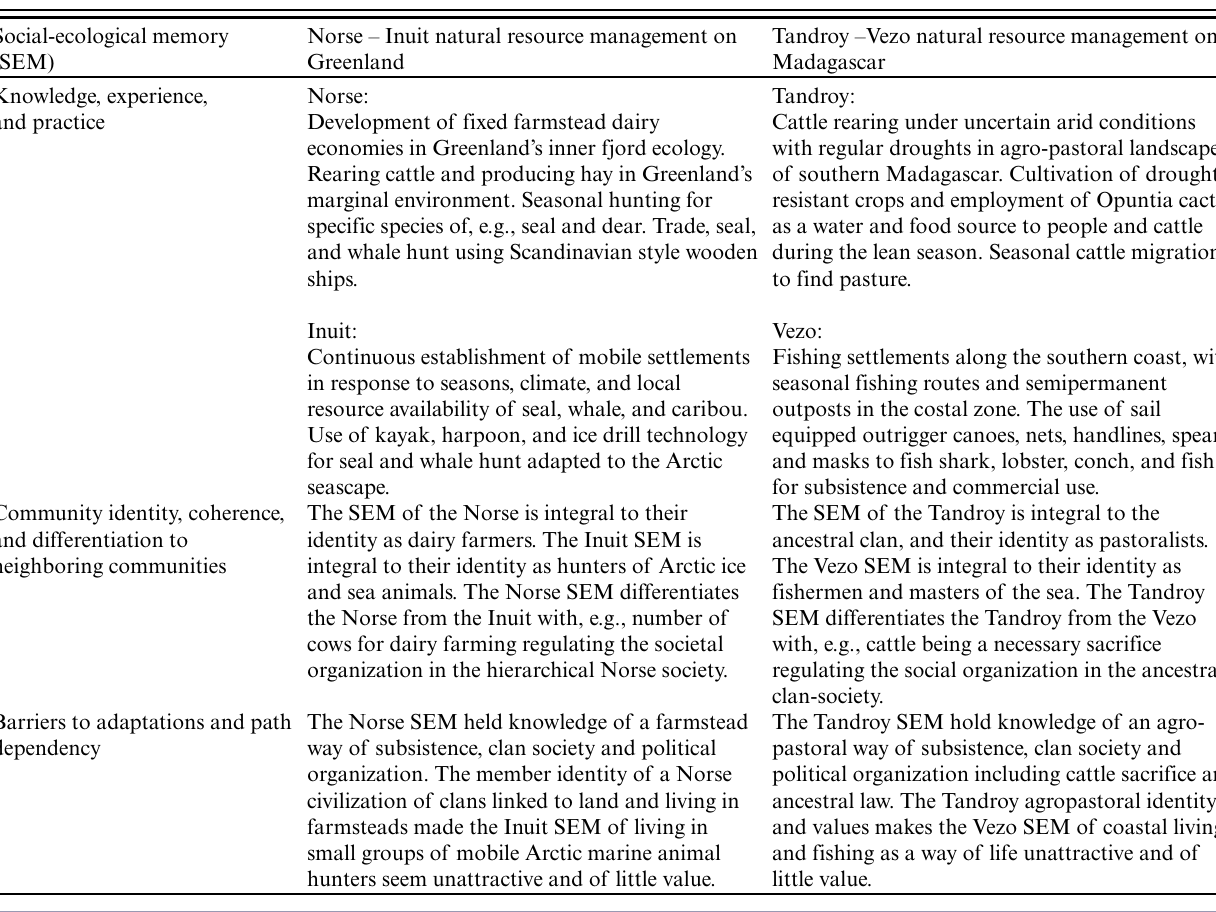
Table 2 . Summary of key results from cases studied.